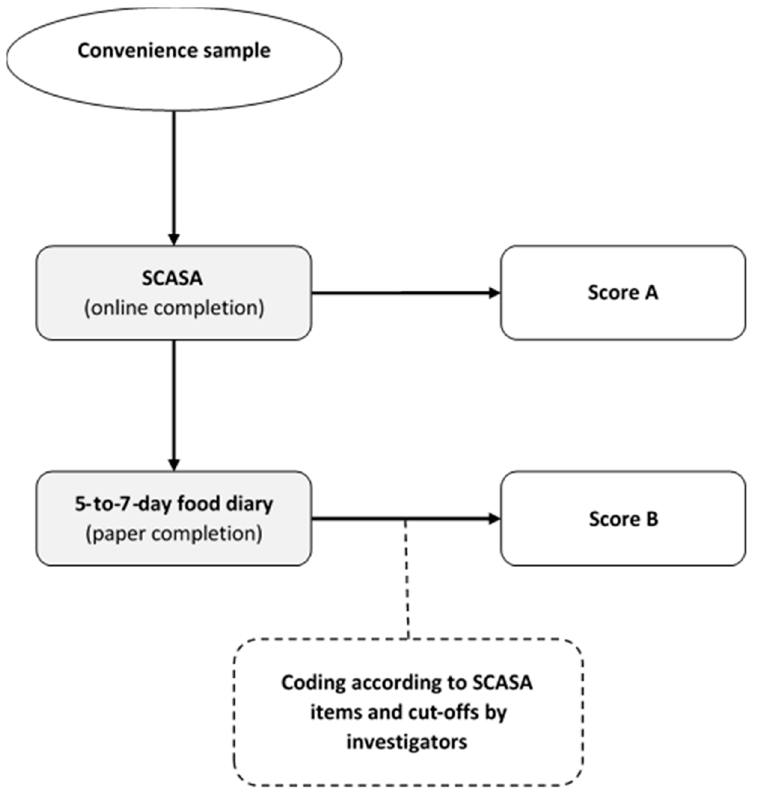
Figure 2. Inter ‐ method reliability assessment of SCASA (score d’alimentation saine). Figure 2. Inter-method reliability assessment of SCASA (score d’alimentation